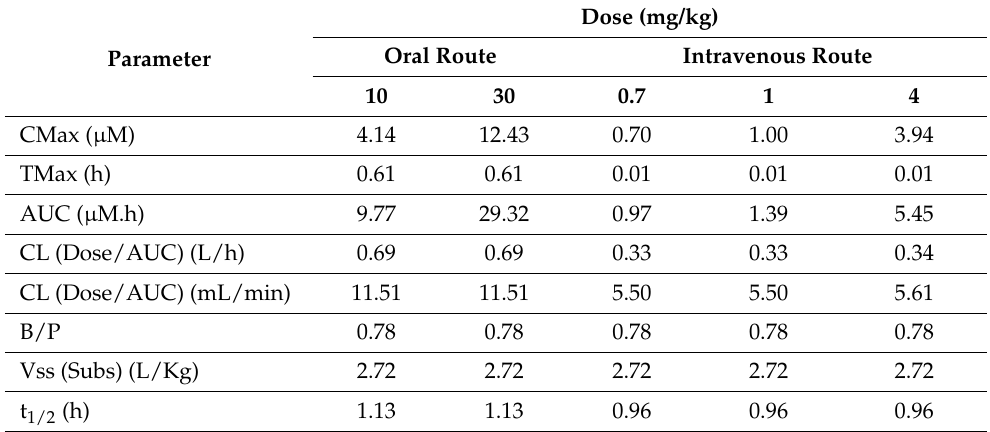
Table 5. LASSBio–1920 PKPD Profiles in animal simulation module.